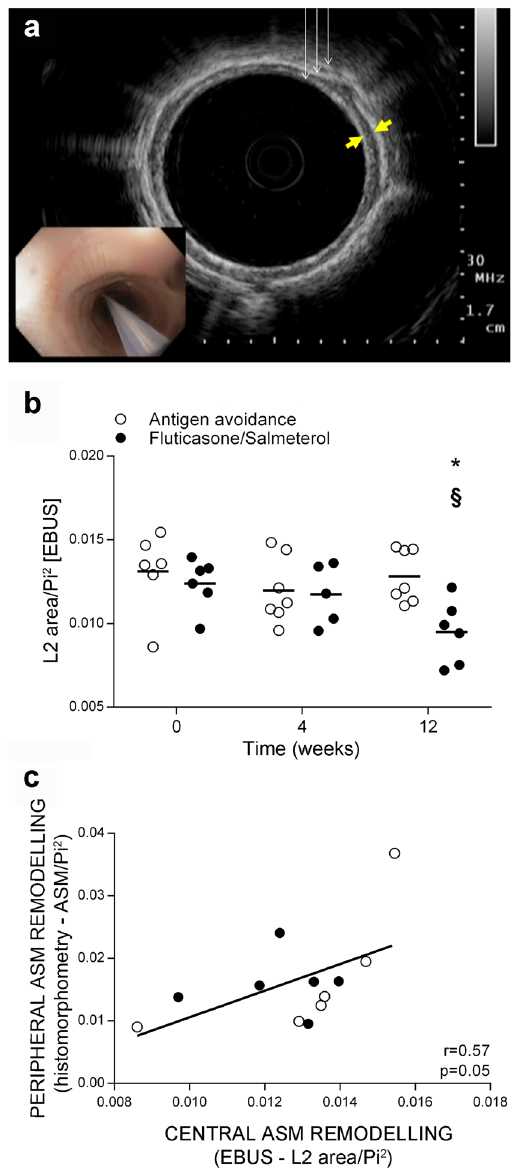
Figure 5. Assessment of central airway remodelling with EBUS. ( a ) Representative image of a central airway obtained with EBUS in a horse with asthma. Thin white arrows indicate the 3 hyperechoic layers of the bronchial wall representing, from the airway lumen going outwards, the bronchial epithelium, the inner, and the outer borders of the bronchial cartilage. The distance between the thick yellow arrows illustrates the thickness of L2. ( b ) EBUS-assessed central airway remodelling in study I. ( c ) Correlation between EBUS-assessed central airway remodelling and peripheral ASM remodelling assessed at histology at baseline (T0) in study I. Each symbol represents one horse (mean value of multiple measures performed). L2: second layer; EBUS: endobronchial ultrasound; ASM: airway smooth muscle; Pi: internal perimeter. * Different from baseline of the same group (p < 0.05); §difference between groups at the time point indicated (p <